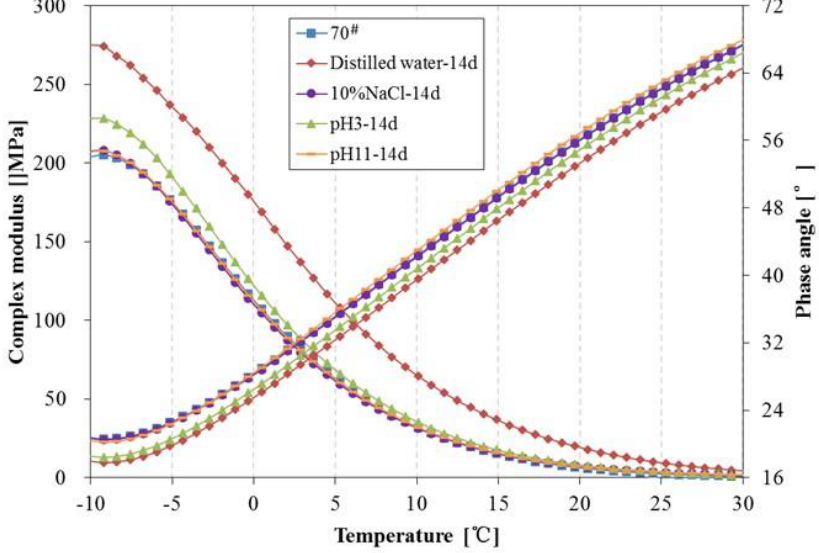
Figure 11. Complex modulus and phase angle of 70 # asphalt before and after 14 days immersion.